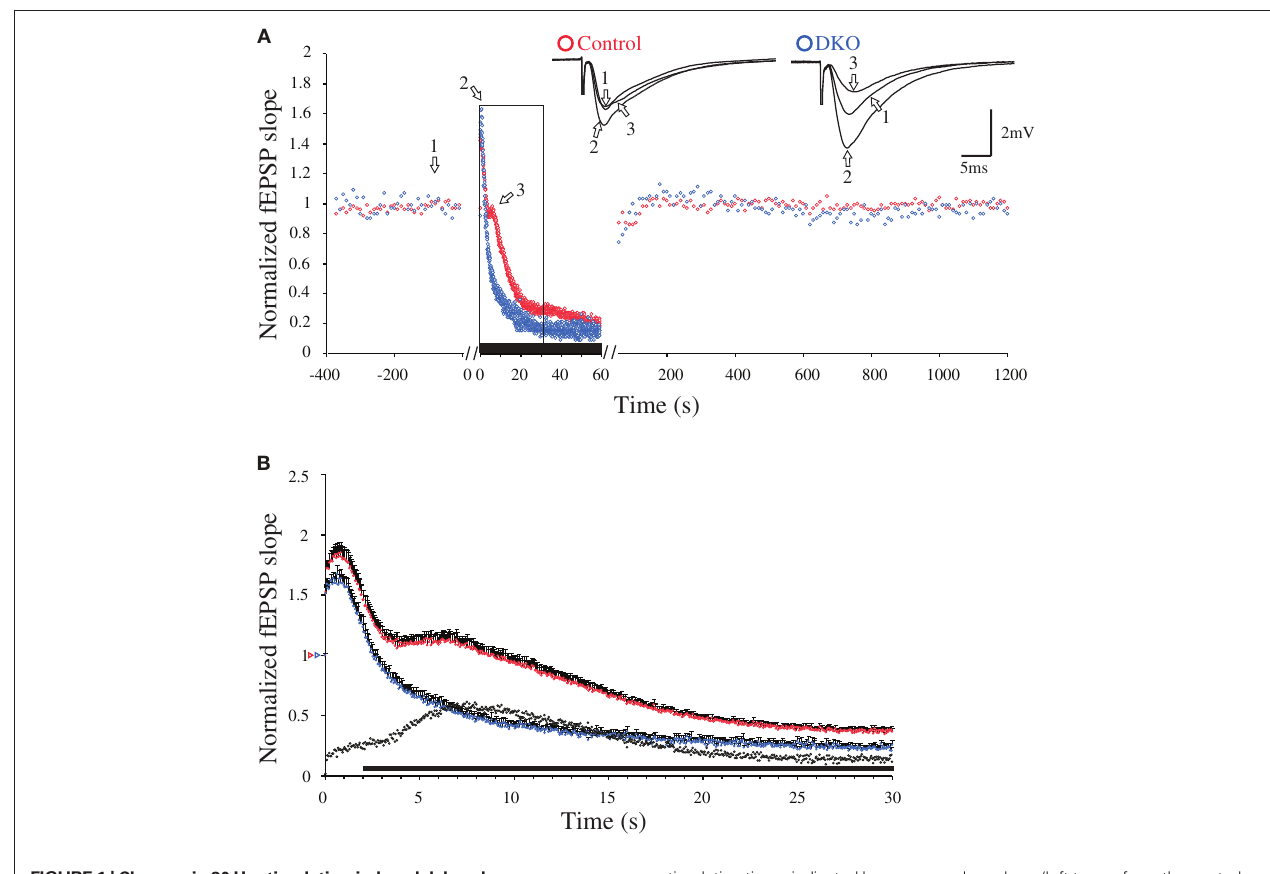
Figure 1 | Changes in 20 Hz stimulation-induced delayed response enhancement (Dre) in hippocampal excitatory CA3-to-CA1 synapses, caused by inactivation of the synapsin i/ii genes. (A) Normalized fEPSP slope measurements during afferent stimulation in stratum radiatum at 0.1 Hz, followed by 20 Hz for 60 s (indicated by black bar, note difference in time scales), and reversal to 0.1 Hz, obtained in two experiments performed at 29 ° C during NMDA receptor blockade (see Materials and Methods). Symbols in blue are from a synapsin I/II double knock-out (DKO) mouse and symbols in red are from a WT mouse, respectively. The insets show superimposed synaptic responses at the